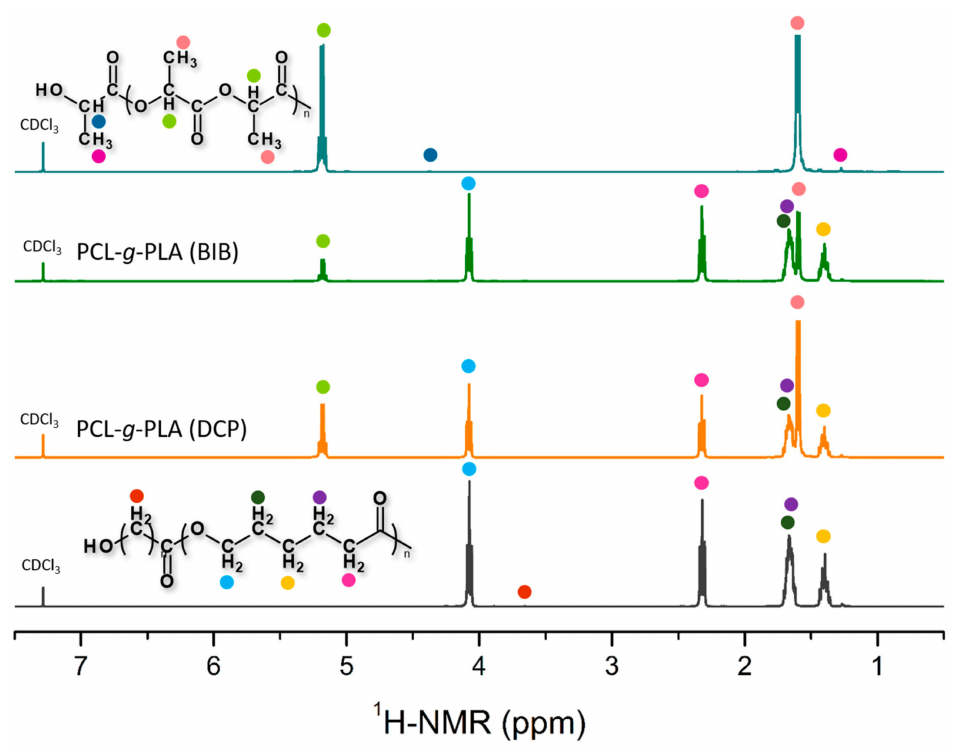
Figure 2. 1 H NMR spectra of neat PCL and PLA, and PCL- g -PLA